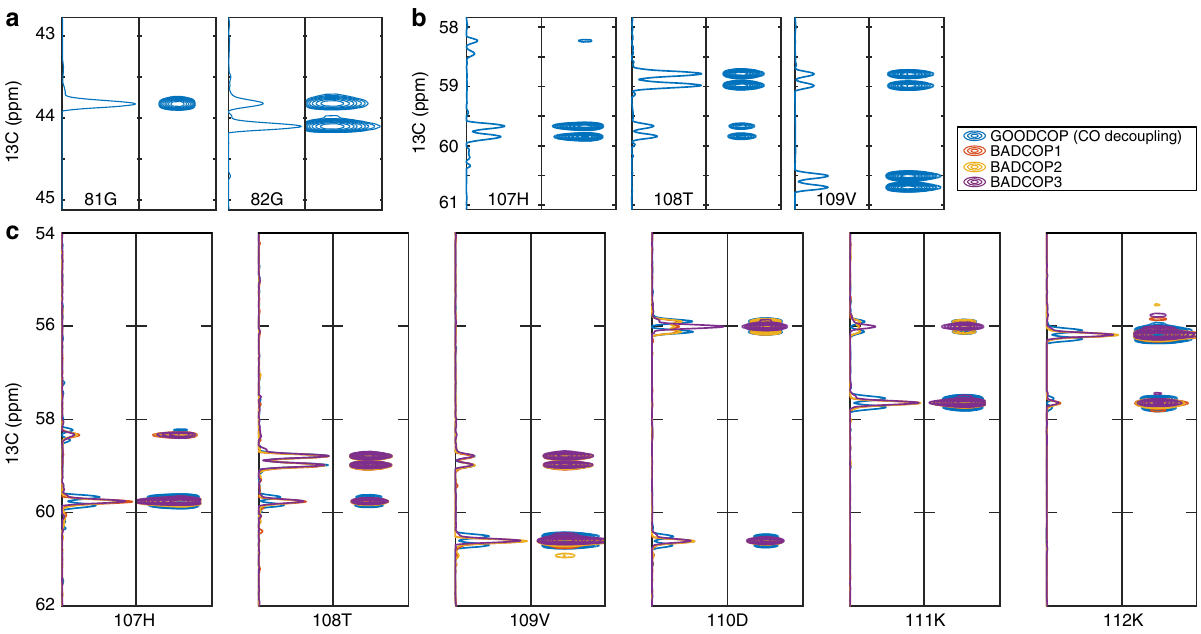
Fig. 5 Using BADCOP1 – 3 line shapes and splitting patterns for sequential assignment. a Strips from a 3D HNCA experiment of HCAii. Glycines appear as singlets and have C α chemical shifts around 45 p.p.m. The strip identi fi ed as “ 82 G ” has an internal and a sequential glycine peak, and the sequential is matched to the strip “ 81 G ” . Two neighboring glycines only occur once in the primary sequence, so these strips can be unambiguously assigned. b In contrast, most peaks appear as doublets because of the C α – C β coupling. These can be be sequentially matched, but assignment onto the primary sequence is dif fi cult without further data or long chains of sequential correlations. c Using three BADCOP decoupling pulses gives residue-speci fi c information. The three leftmost strips (the same strips as in b ) show a particular sequence of different splitting patterns under the various decoupling pulses, as described in Fig. 3a. This pattern is only consistent with one location on the primary sequence of HCAii and so these can be unambiguously assigned. Further sequential matches show splitting patterns consistent with the primary sequence and the expected splitting patterns based on Fig. 3a. This gives many opportunities to make or con fi rm assignments. All acquisition and processing settings are the same for the four spectra, while strip contour levels are set individually for visual clarity. An expanded version of this fi gure is included as Supplementary Fig.